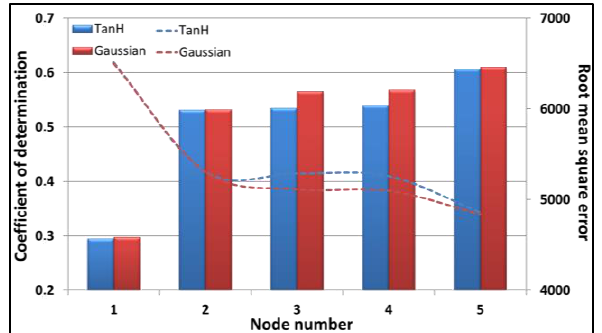
Figure 4 . Barplot of the neural network models’ test results for one hidden layer for separate hyperbolic tangent (TanH) and Gaussian (Gauss)